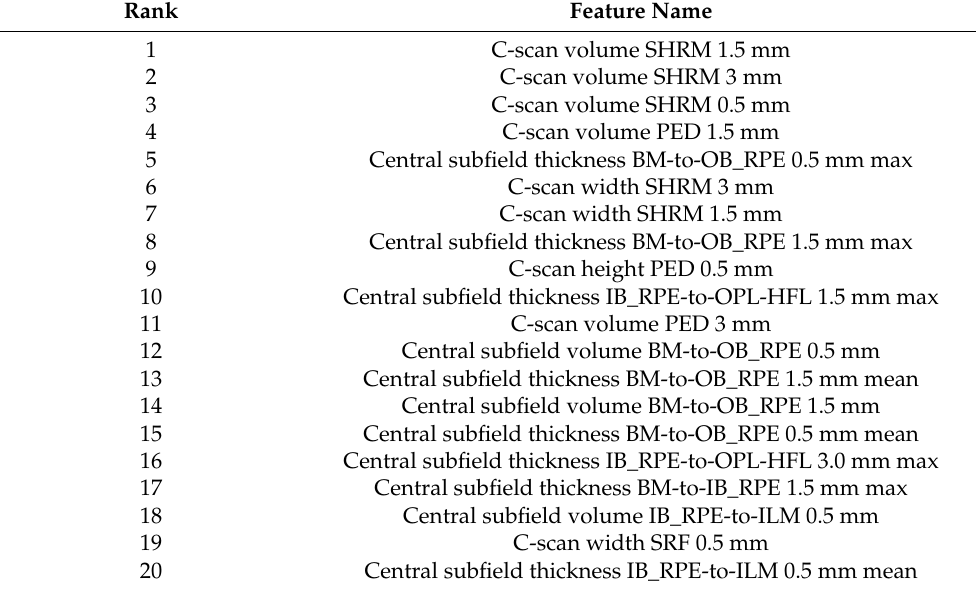
Table 6. The features from Figure 4B in descending order of importance. BM, Bruch’s membrane; HFL, Henle’s fiber layer; IB, inner boundary; ILM, inner limiting membrane; max, maximum; OB, outer boundary; OPL, outer plexiform layer; PED, pigment epithelial detachment; ROC, receiver operating characteristic; RPE, retinal pigment epithelium; SHRM, subretinal hyperreflective material;